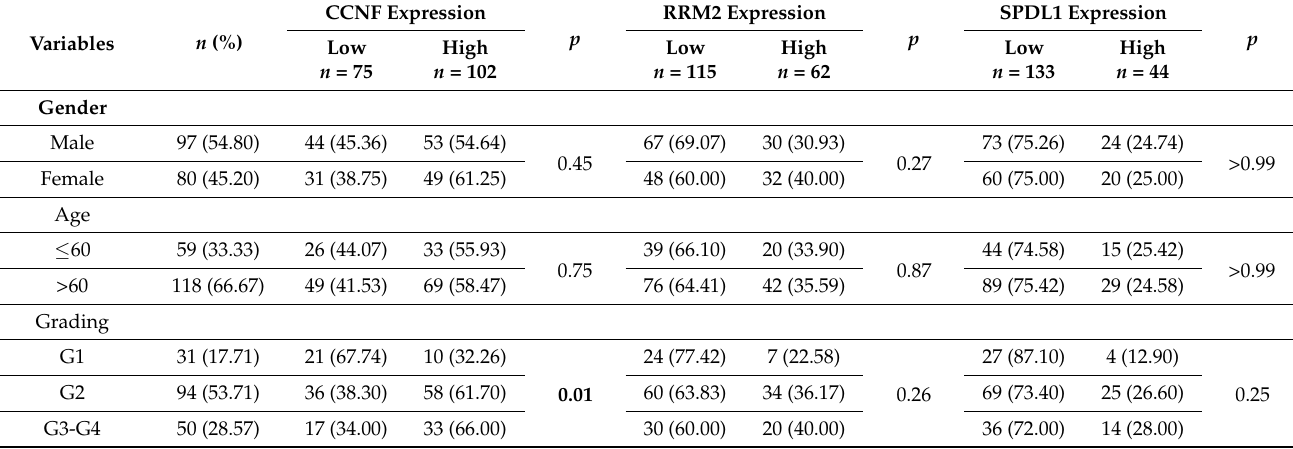
Table 2. Association of CCNF, RRM2, and SPDL1 and the clinicopathological features in TCGA cohort of PAC patients ( n = 177).